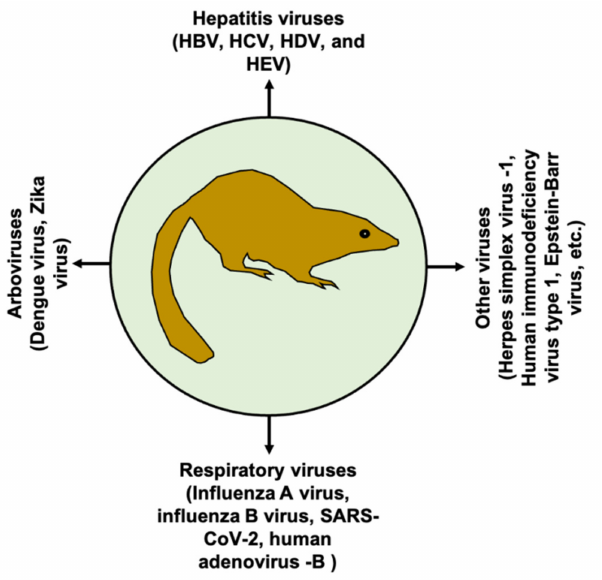
Figure 1. Tree shrew as a model of human viral infections. The tree shrew has been modeled for several important human viral pathogens as indicated in the